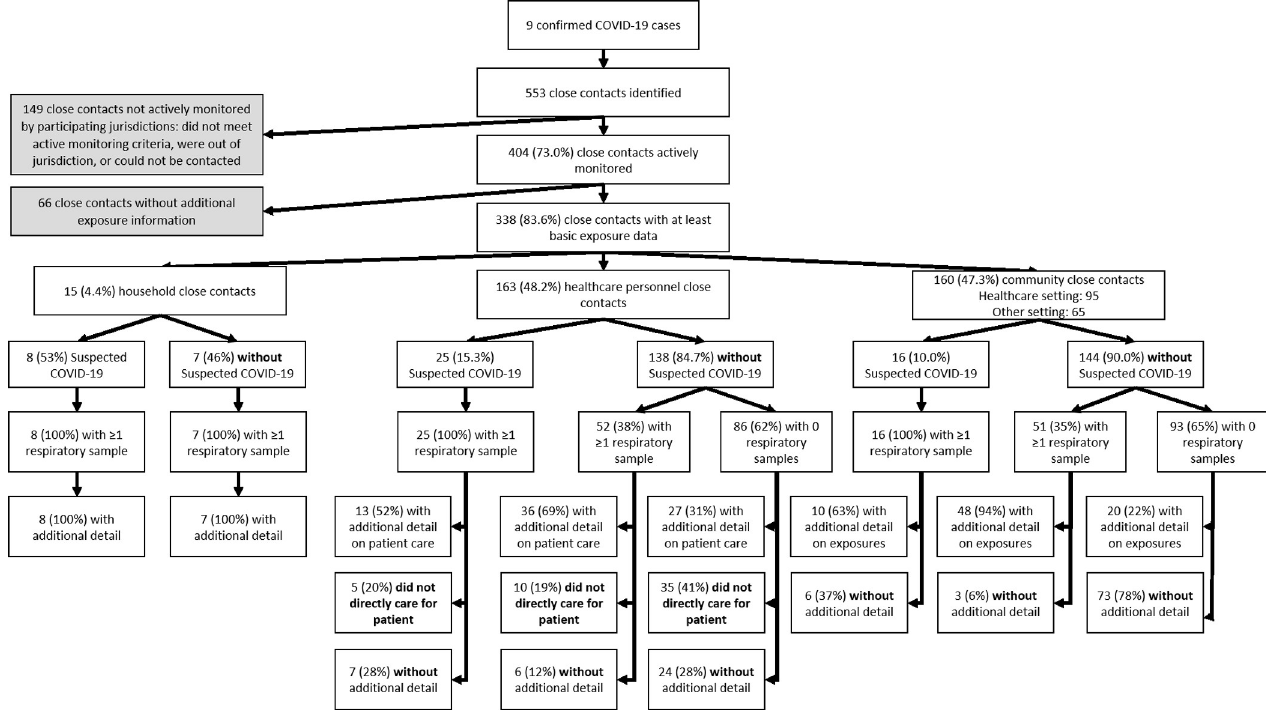
Fig 1. Flow diagram of close contacts identified and included in enhanced contact investigations centered on 9 COVID-19 patients, United States, January–February 2020.